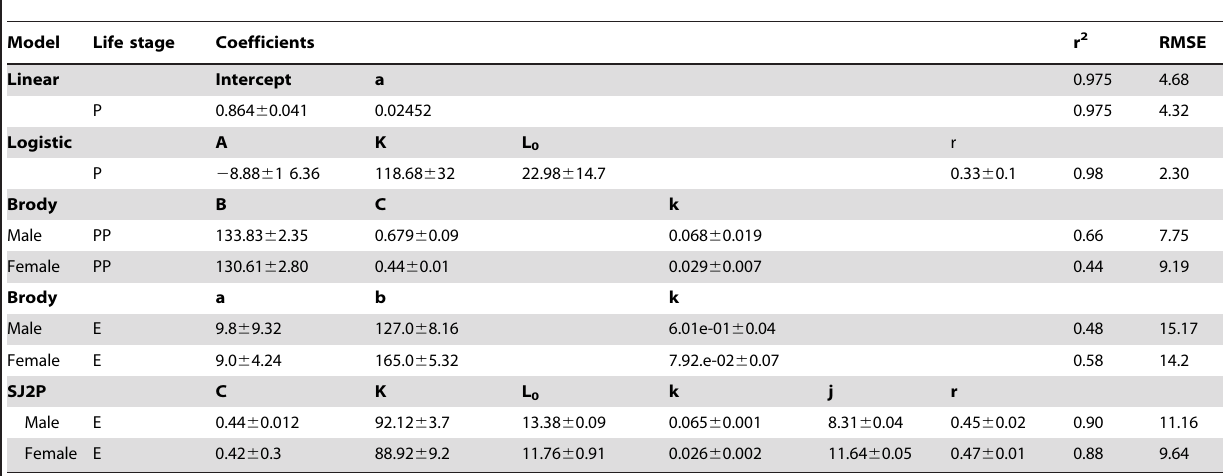
Table 2. Coefficients of the linear and Brody growth models describing head length growth of pouch young and post-weaned Tasmanian pademelons ( Thylogale billardierii